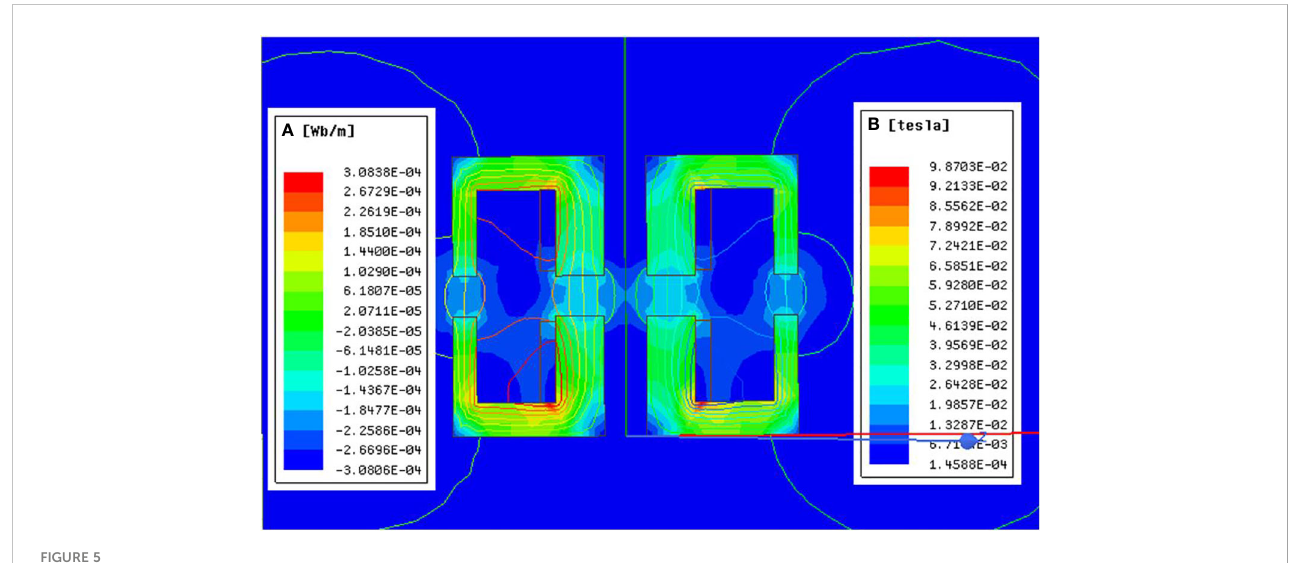
FIGURE 5 The magnetic fi eld simulation of the coil.